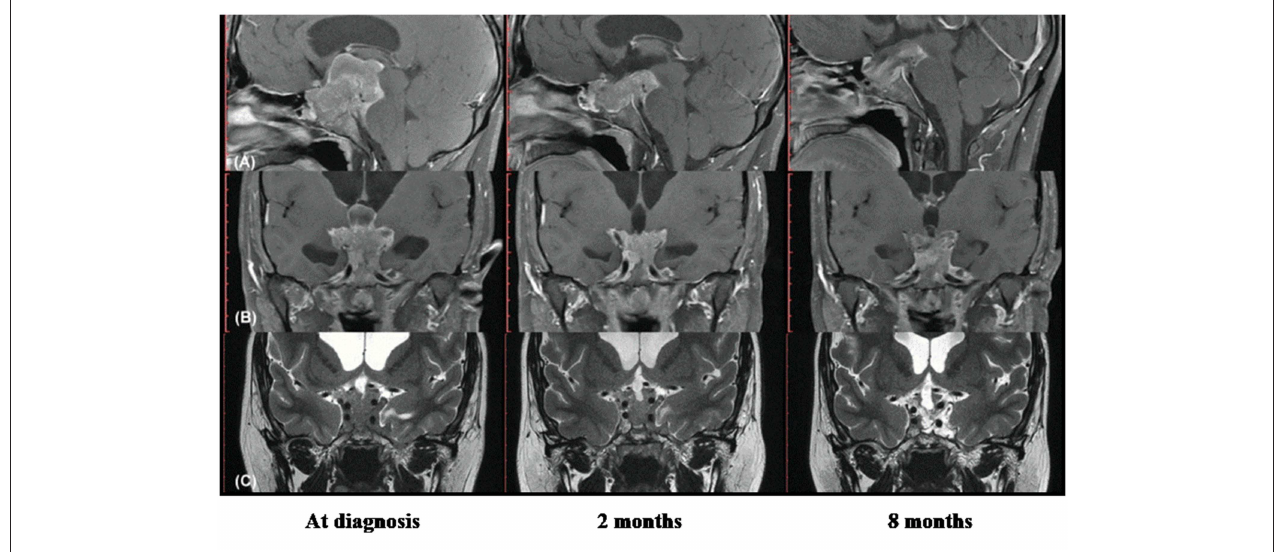
FIGURE 1 | Radiological images showing remarkable therapeutic response with cabergoline in young man with hydrocephalus and intracranial hypertension for giant prolactinoma as first clinical manifestation of multiple endocrine neoplasia type 1. (A) Magnetic resonance imaging (MRI) in T1 with gadolinium, sagittal section; (B) MRI in T1 with gadolinium, coronal section; (C) MRI in T2 with gadolinium, coronal section. Left images show the solid-cystic sellar and parasellar tumoral mass identified at diagnosis (7.5 × 4.4 × 3.6cm), with invasion of cavernous sinus, midbrain and third ventricle, occluded foramen of Monro and moderate to severe supratentorial obstructive hydrocephalus; Central images obtained 2 months after the beginning of cabergoline shows significant reduction of the tumor. Right images, with 8 months of cabergoline reveal a notable tumoral shrinkage and necrosis of the tumor. TABLE 1 | Outcome of pituitary hormones during first-line treatment with dopaminergic agonist of MEN1 case with giant prolactinoma. Hormones At diagnosis 20 1 days